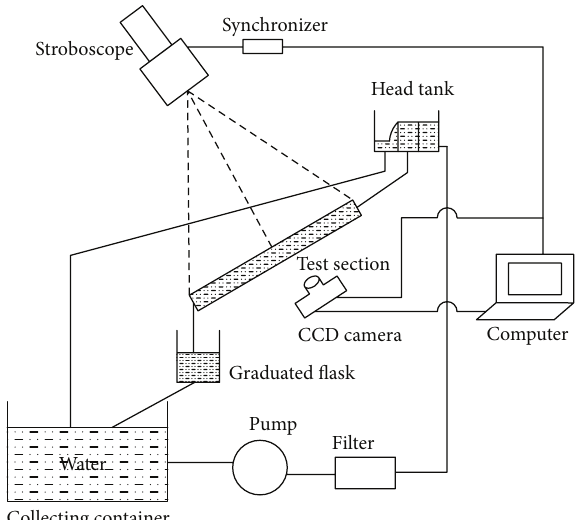
Figure 1: Schematic diagram of experimental